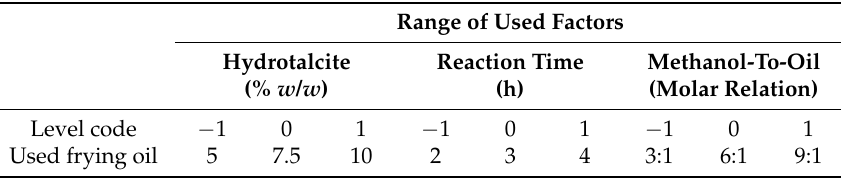
Table 2. Experimental design for biodiesel optimization—experiment.